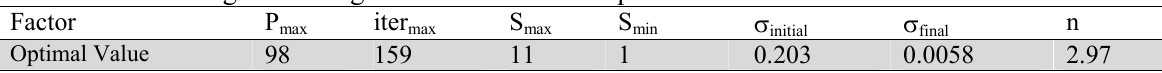
Results of IWO Algorithm Regulation for Portfolio Optimization Problem Factor P iter max